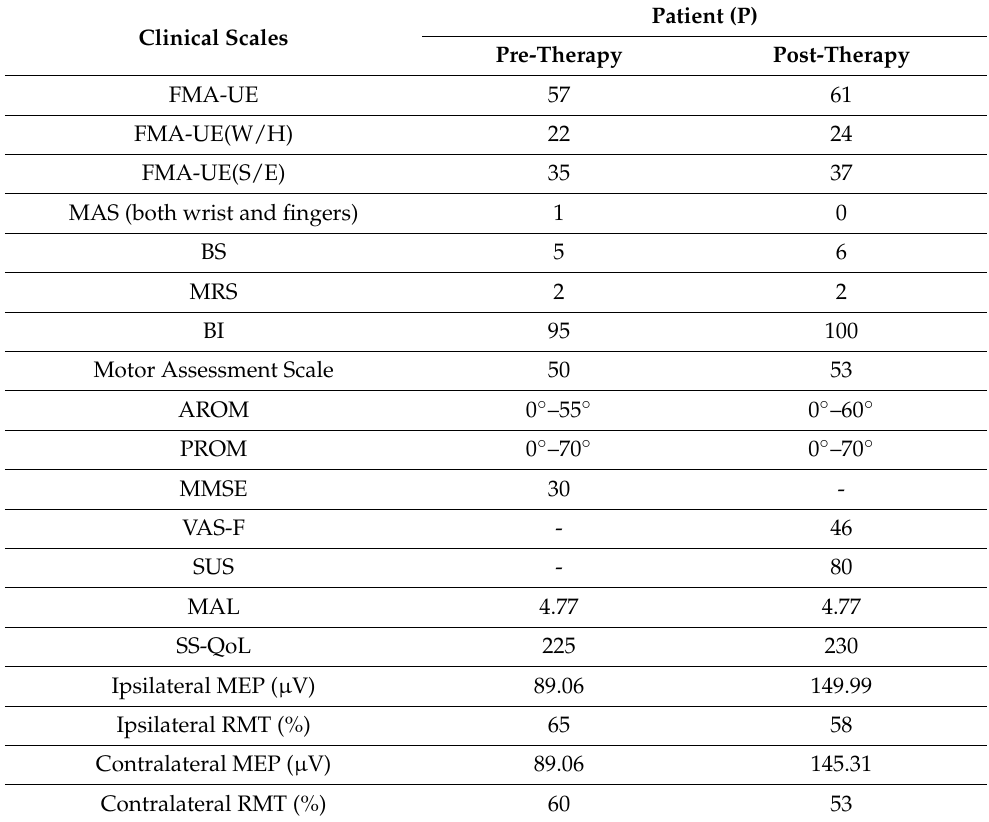
Table 1. Details of clinical scales and cortical excitability measures acquired from patient ‘P’. Clinical